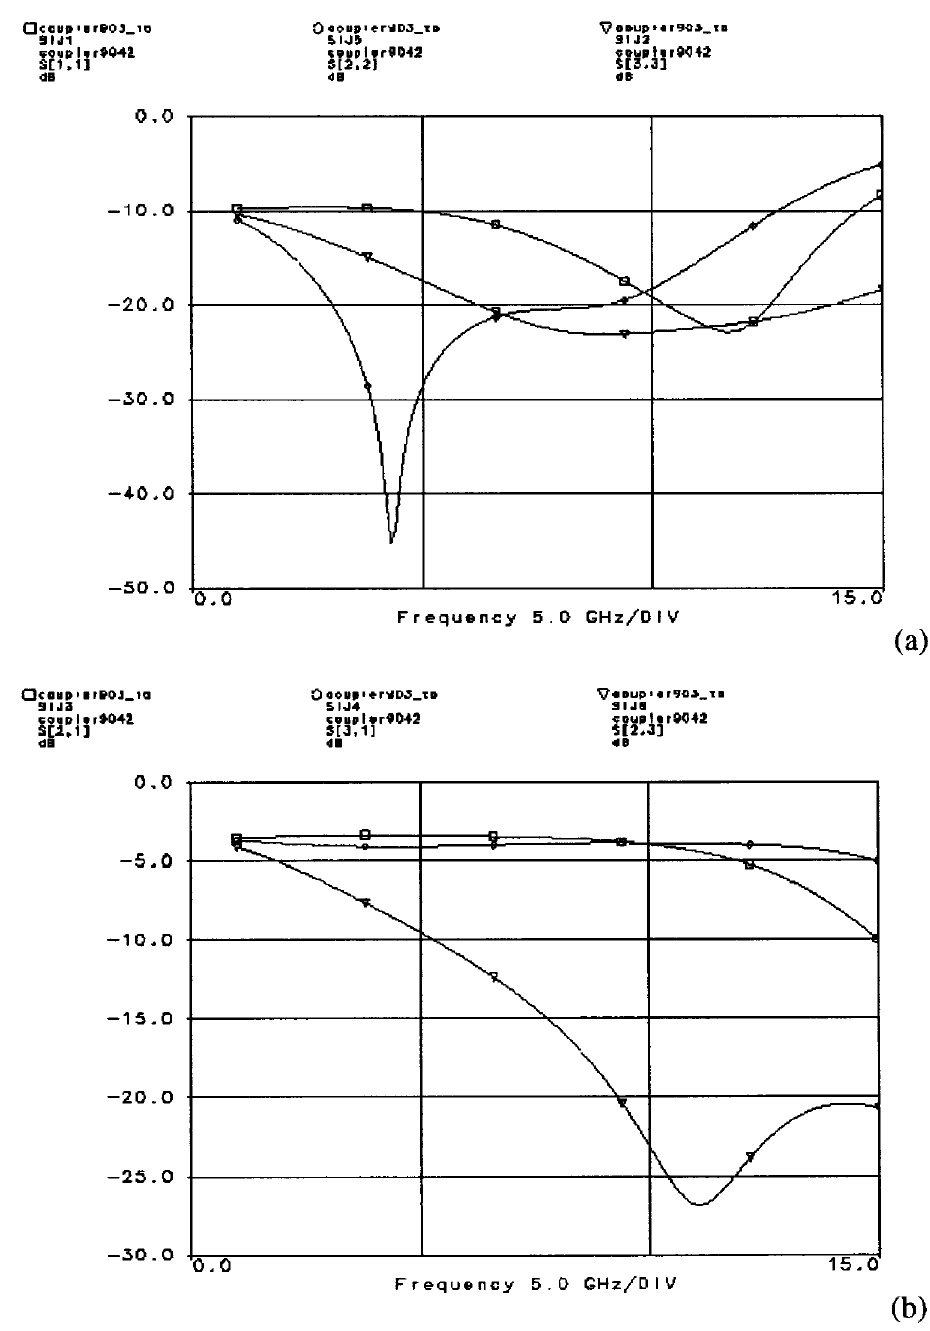
FIGURE 10 (a) j s 11 j ; j s 22 j and j s 33 j parameters of the 90-deg coupler. (b) j s 21 j ; j s 31 j and j s 23 j parameters of the 90-deg